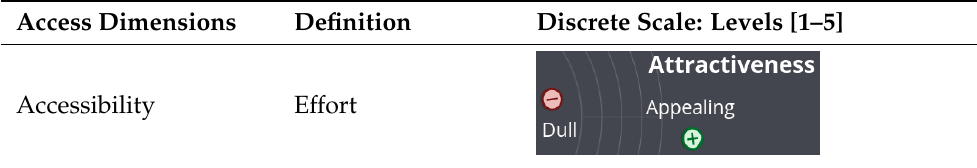
Table 2. New scaled access dimension introduced in this